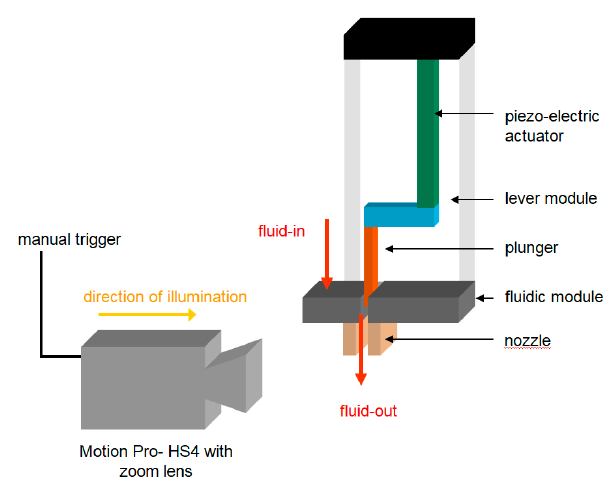
Figure 2. Experimental setup of jetting apparatus and high-speed image acquisition.